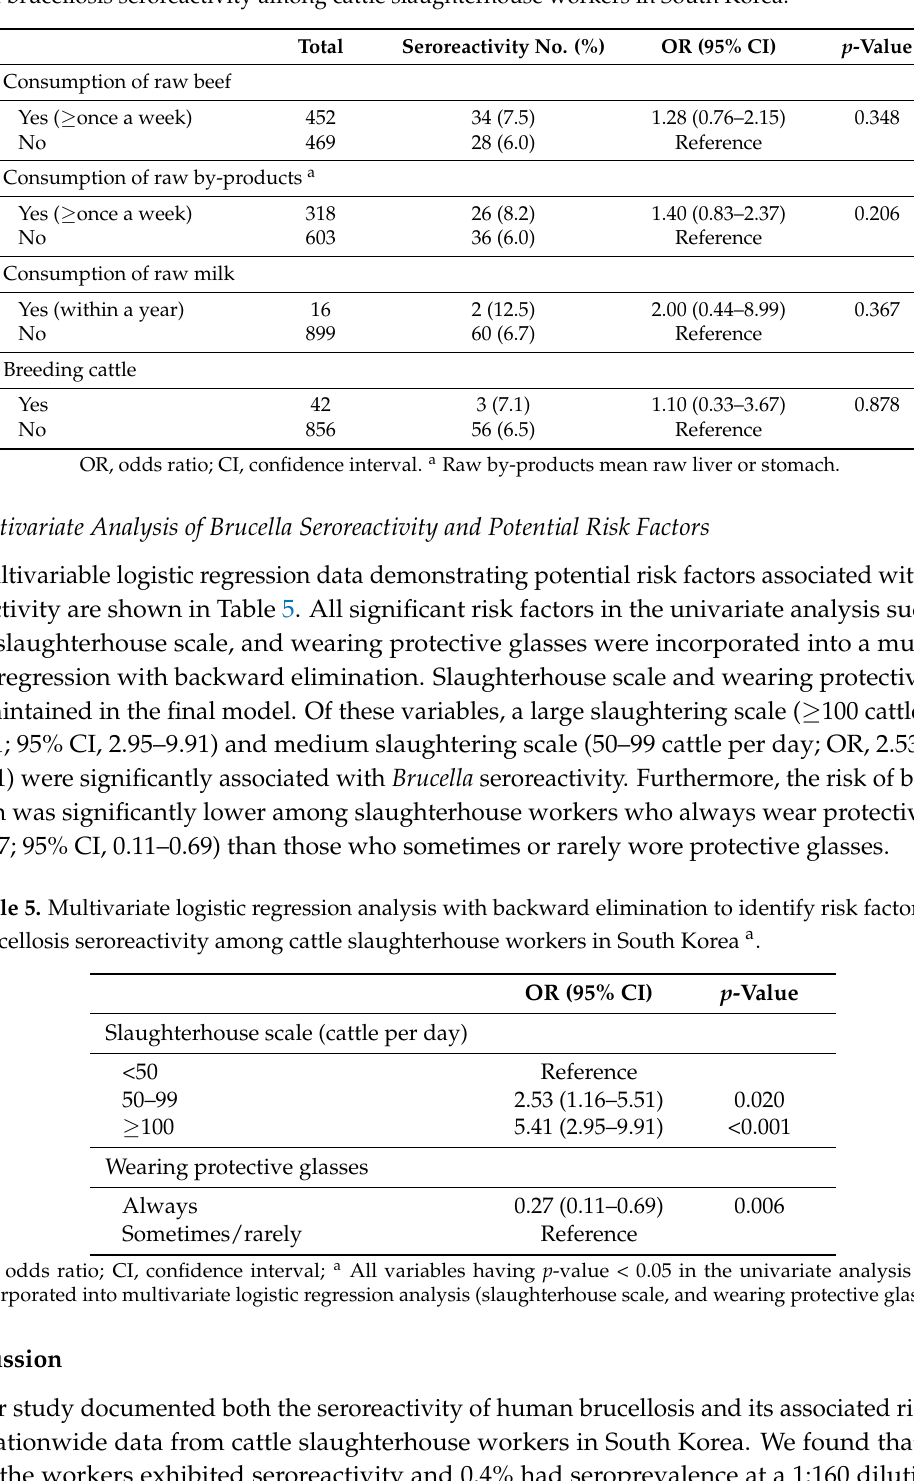
Table 4. Univariate logistic regression analysis of the association between other potential risk factors and brucellosis seroreactivity among cattle slaughterhouse workers in South Korea.